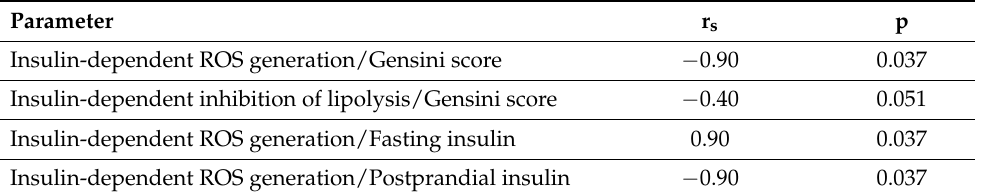
Table 8. The correlation between insulin sensitivity and insulin resistance of EAT adipocyte with Gensini score or postprandial insulin.